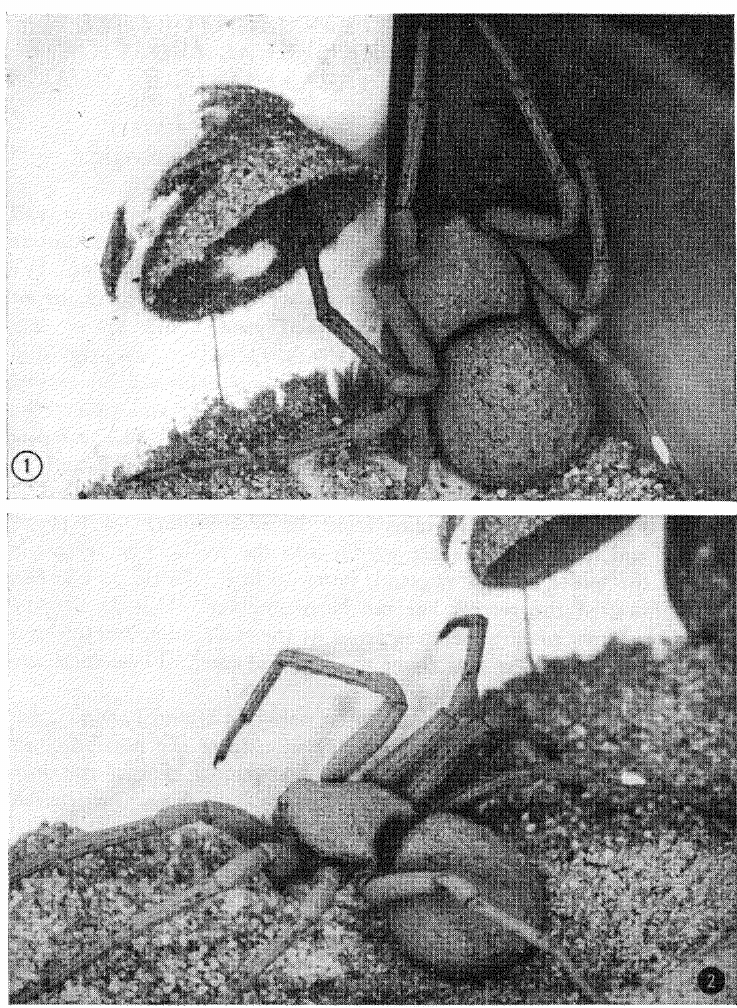
Fig. 1. Sicarius "sp. 1" female with the foundation of the eggcase. The basal disc still has a bare spot, while the upper rim has been built up. On the left side are some foundation attachments not used. The sand next to the spider on the ground has been scraped away to the bottom of the con- tainer, while in later photographs sand has been thrown back into this area by the spider. The total length of the spider is 18 mm. The photo- graph was taken on 13 June. Fig. 2. Female Sicarius rocking her abdomen in the sand. The abdomen is held at an unusual angle to the prosoma while picking up fine sand particles. The photograph was taken later on 13